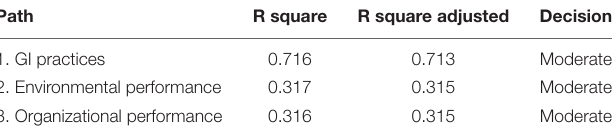
TABLE 5 | Analysis of R 2 .